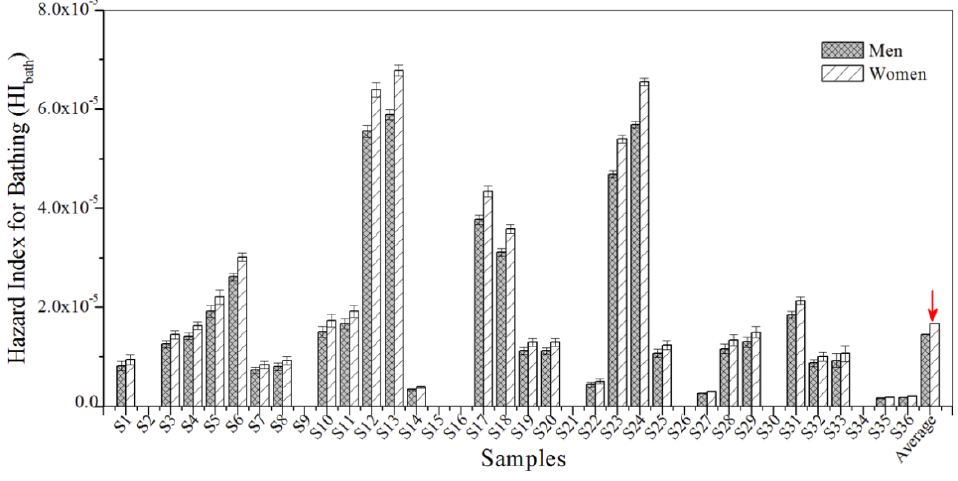
Figure 6. The HI bath for BBP in the urban sewage samples.